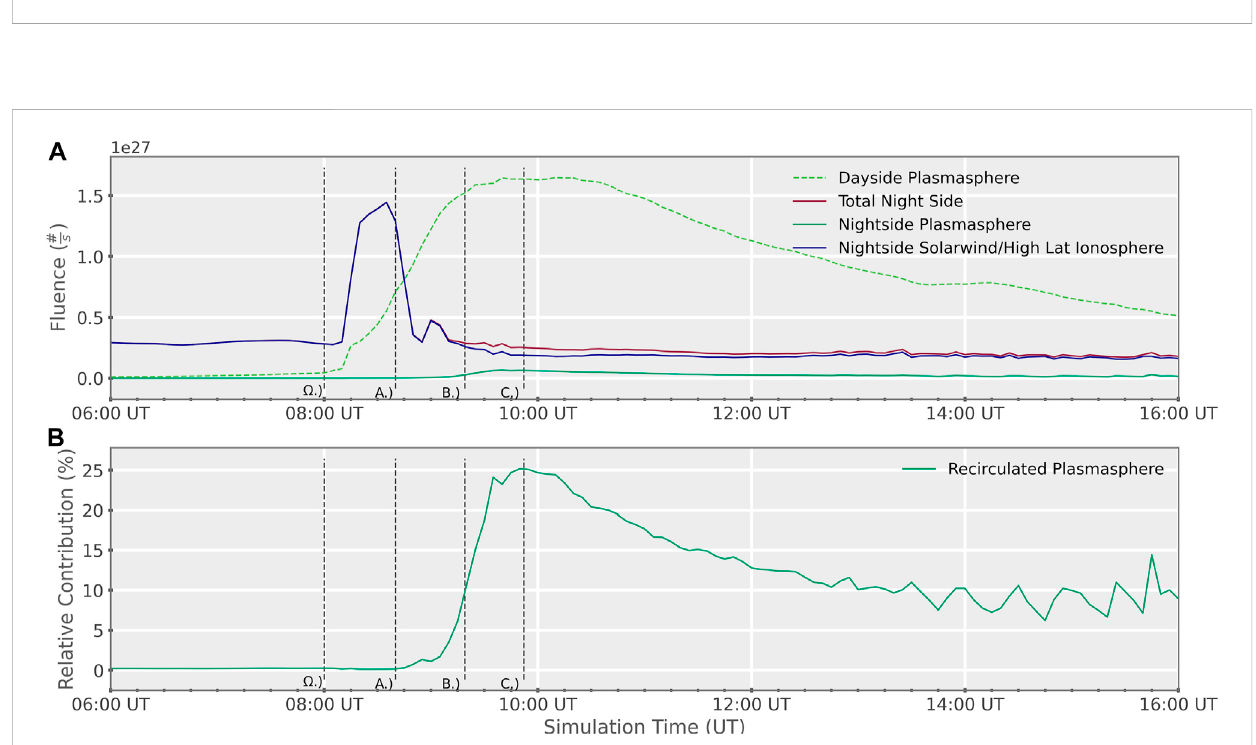
FIGURE 7 Theverticallinemarked ‘ Ω .) ’ correspondstothebeginningofthestorm.Theverticallinesmarked ‘ A.) ’ , ‘ B.) ’ , ‘ C.) ’ correspondtothetimesshowninthe left, center, and right columns of Figures three to six respectively. (A) Fluence of the BATS-R-US fl uids as they cross the measurement boundaries on the day and night side 1. “ Dayside Plasmasphere ” corresponds to the fl uence of the plasmasphere material through the dayside plume. “ Total Night Side ” referstothetotal fl uenceofall fl uidspassingthroughthenightsidemeasurementboundary. “ NightsideSolarwind/HighLatIonosphere ” referstothe fl uence of the combined solar and polar wind across the night side boundary. “ Nightside Plasmasphere ” refers to the fl uence of the recirculating plasmaspherethroughthenightsidemeasurementboundary. (B) Relativecontributionoftherecirculatingplasmaspheretothetotal fl uencecrossingthe nightsidemeasurementboundaryintheIdealSquareWaveevent1.At0%thereisnorecirculatingplasmasphere,at50%therecirculatingplasmasphereis contributing equally to the combined solar and polar